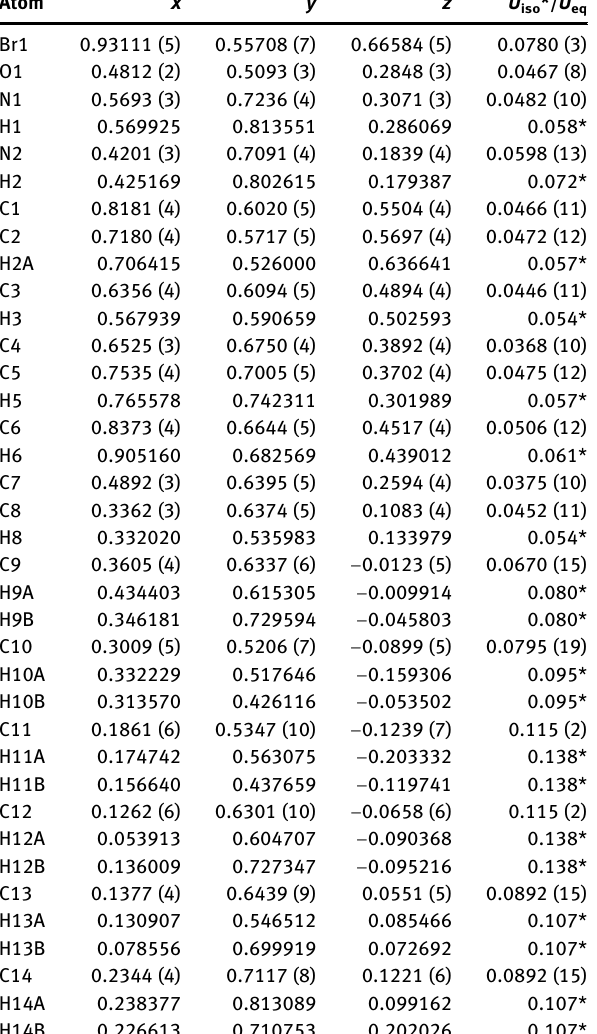
Table  : Fractional atomic coordinates and isotropic or equivalent isotropic displacement parameters (Å 